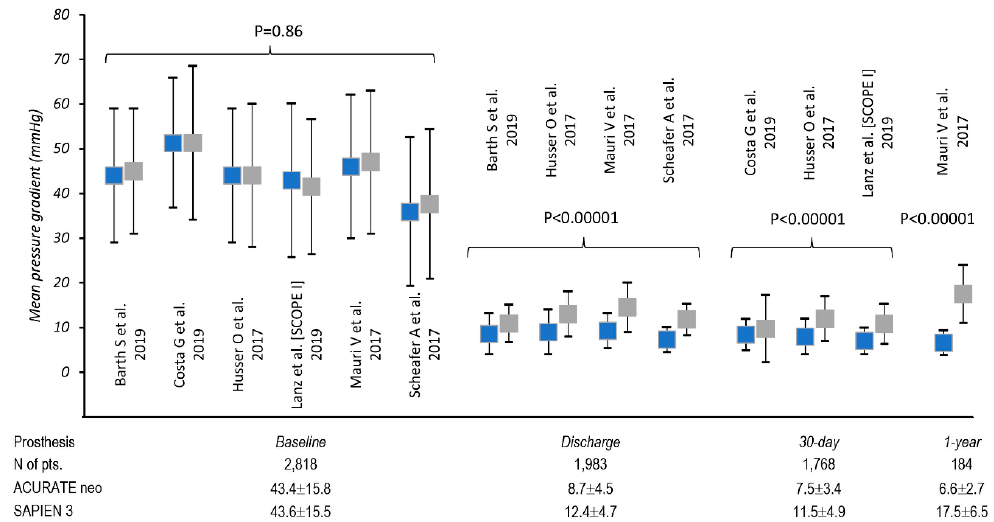
Figure 2. Figure 2. Analysis of mean transaortic gradients before and after transcatheter aortic valve replacement (TAVR).